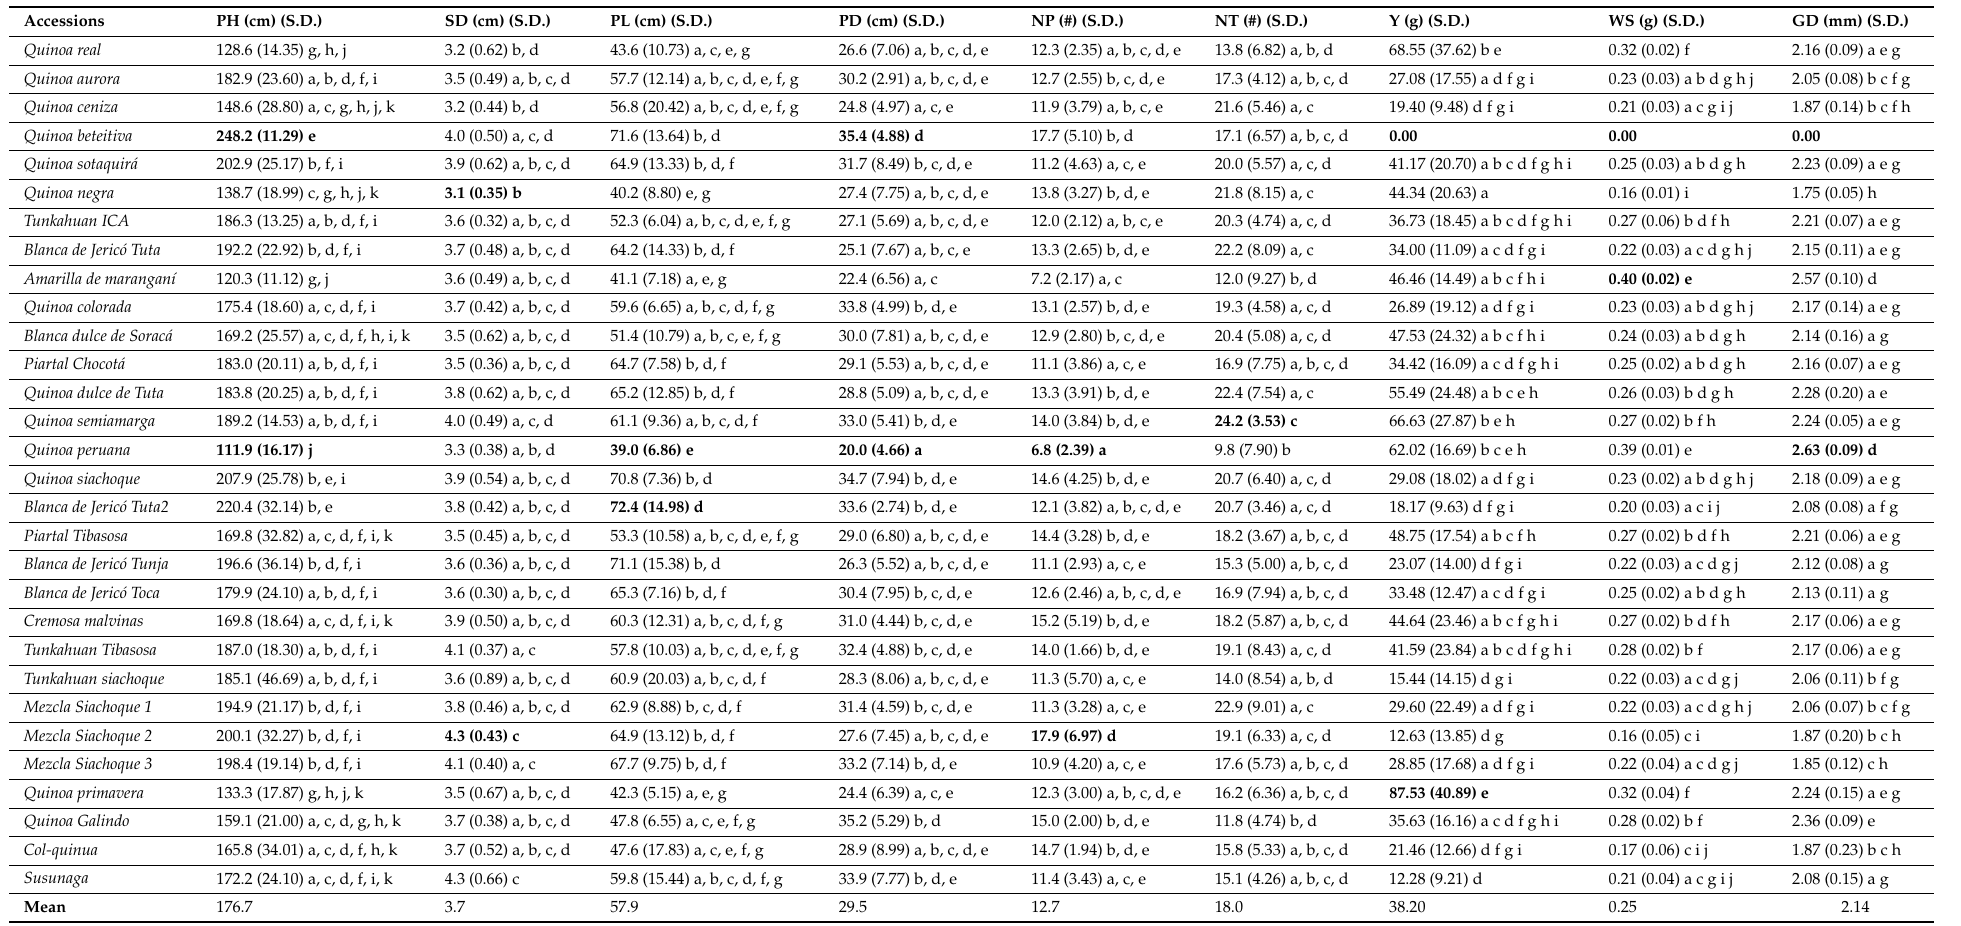
Table 1. Averages, standard deviation, and Tukey multiple comparison (MC) for the quantitative variables of the thirty quinoa